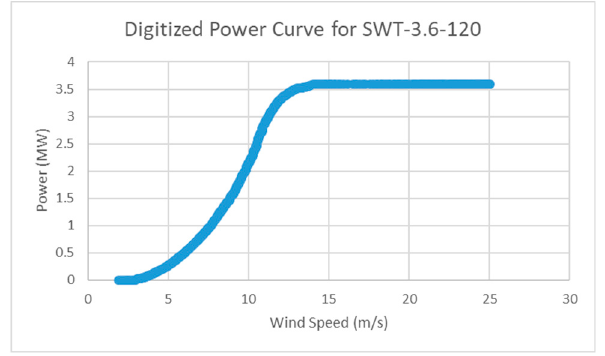
Figure 11. Typhoons with greater than 250 km/h.